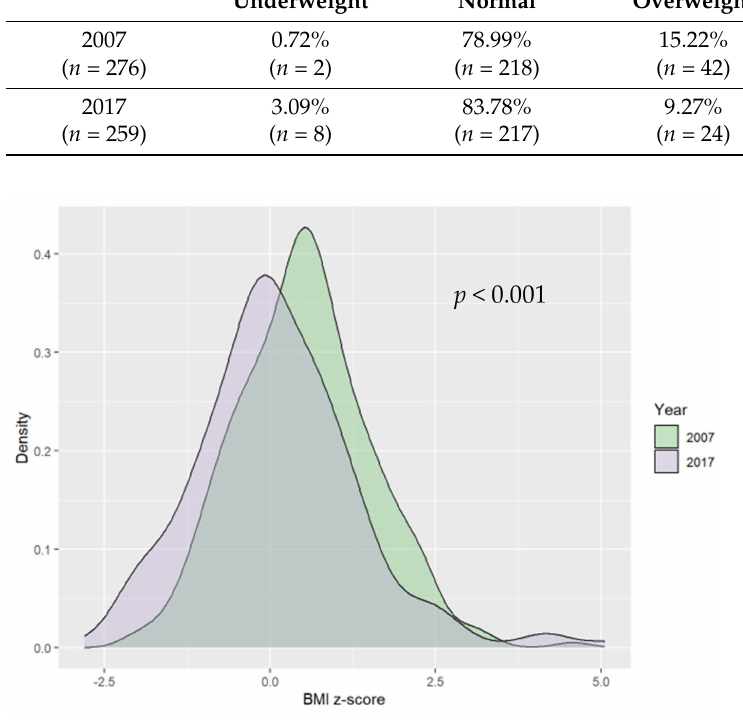
Figure 1. Ten − year differences in body mass index (BMI) z − scores.